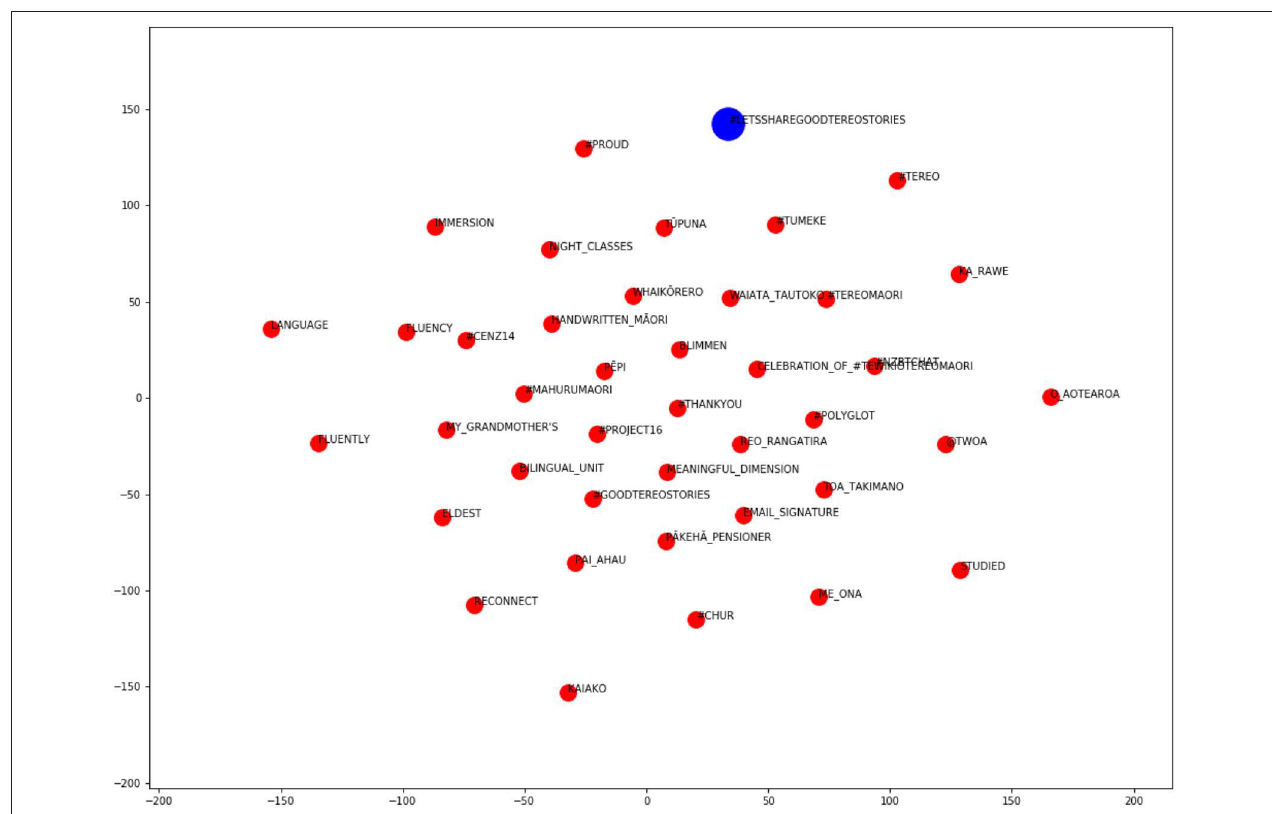
FIGURE 5 | Word embedding plot for the hashtag #letssharegoodtereostories.